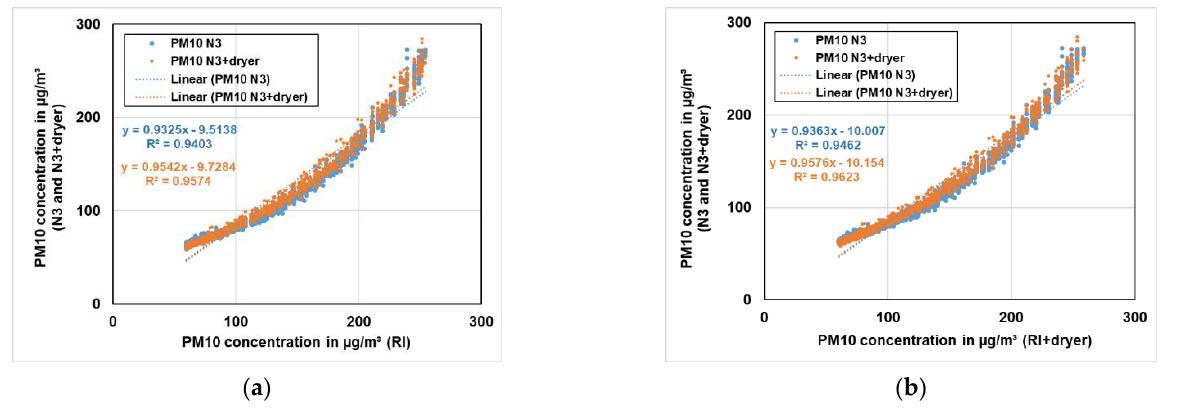
Figure 18. ( a ) Comparison of PM10 concentration of the reference instrument (RI) to the PM10 concentration of both low-cost PM sensors (N3 and N3+dryer) with the same dryer settings. ( b ) Comparison of PM10 concentration of RI+dryer to the PM10 concentration of both low-cost PM sensors (N3 and N3+dryer) with the same dryer settings.